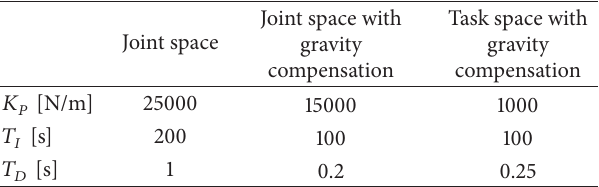
Figure 12: Joint-space PID with gravity compensation: platform’s trajectory in task-space (a) and joint space errors (b). Table 1: PIDs gains.